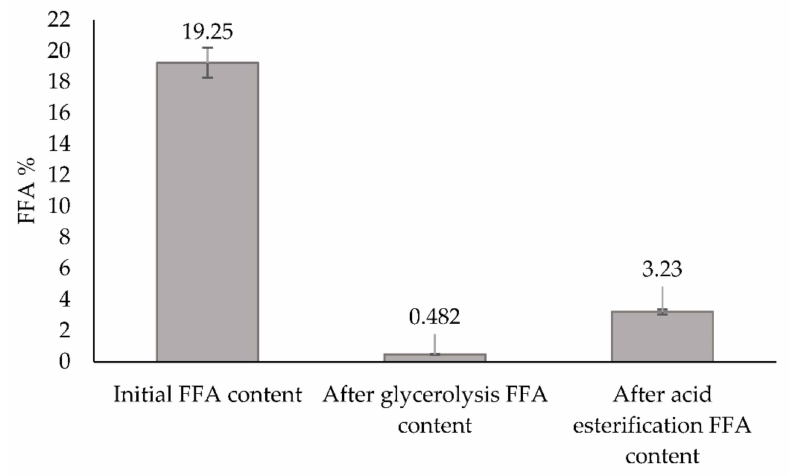
Figure 18. Impact of glycerolysis and acid esterification on feedstock FFA